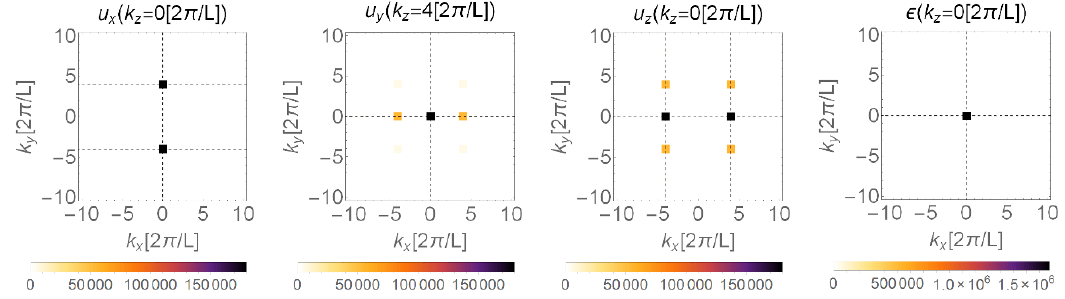
Figure 10 . Constant k slices of the velocity (cid:12)eld and the energy density at the (cid:12)nal ( t = 10 (cid:28) ) phase of a three dimensional (cid:13)ow with initial mode n = 4. Other modes, not exhibited in these slices are sub-dominant. The dominant modes at late times are the same as the ones injected at t = 0. See equation